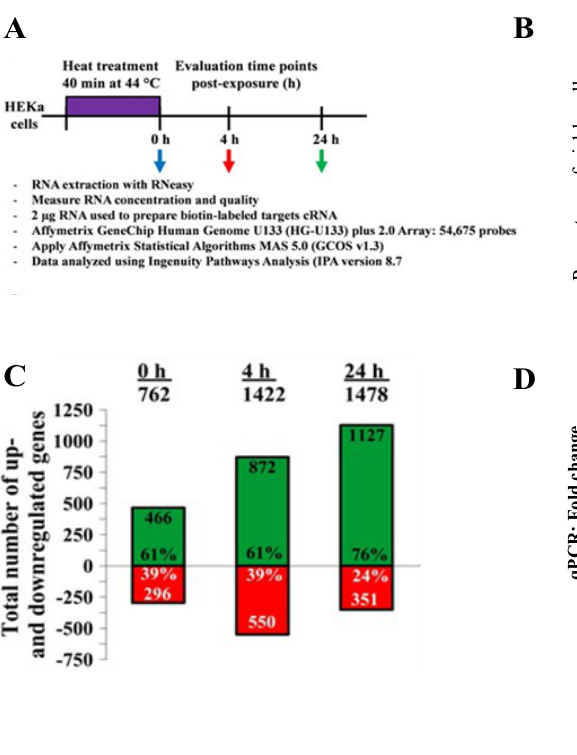
Figure 1. ( A ) A schematic of the heat shock exposure protocol and post analysis techniques. ( B ) Cellular MTT viability for keratinocytes exposed to hyperthermic stress. Viability percentage data (relative to untreated samples) was measured for wells with concentration densities ranging from 10,000 to 100,000 cells per well. Viability was measured at 0, 4 and 24 h post-heat treatment. ( C ) Microarray global gene expression profiles. The data shows that 762, 1,422 and 1,478 total genes were differentially expressed at 0, 4 and 24 h post-exposure, respectively. ( D ) Gene expression for minimal stress protein, heat shock protein 70 (HSPA6) using qRT-PCR. The mRNA expression fold values were measured for sham and heat treatment groups. For each time point, three samples (S1, S2 and S3) were assessed, each in triplicates. Values were calculated in relation to β-actin and normalized to a separate RNA